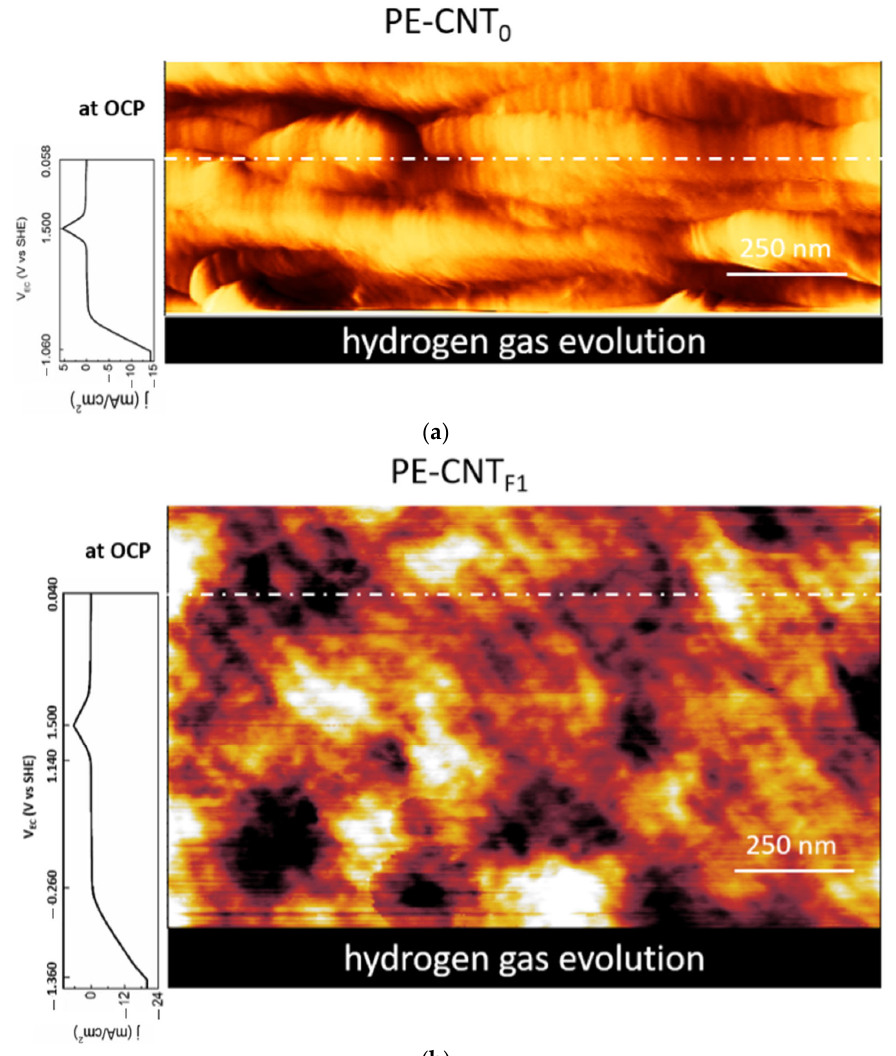
Figure 8. Surface morphology images of the CNTs ‐ based nanocomposites immersed inside the electrolyte (H 2 SO 4 1 M) and synchronized with the cyclic ‐ voltammetry. ( a ) PE ‐ CNT 0 [(1.50 × 0.55) μ m 2 ] and ( b ) PE ‐ CNT F1 [(1.50 × 0.88) μ m 2 ] sample. The ( a ) and ( b ) scanned areas have dissimilar sizes due to different scan rates (1.5 nm/s and 3.0 nm/s, respectively) used to optimize the image quality during the acquisition. The cyclic ‐ voltammetry scan rate is 10 mV/s for both images. Starting from the top of the images (both a and b panels), the electrochemical potential was initially set at the OCP value. From the white dot ‐ dash line, the cyclic ‐ voltammetry was synchronized with the AFM tip scan. Each line of the latter corresponds to a different potential value, as reported in the voltammograms placed on the left of the images. No changes were observed in the surface morphology regarding roughness or dependency on the voltage applied. Nonetheless, when we reached the cathodic current enhancement region (at about − 1.0 V vs. SHE), the AFM acquisition became unstable, and it was not possible to proceed with the data acquisition. This is due to the evolution of